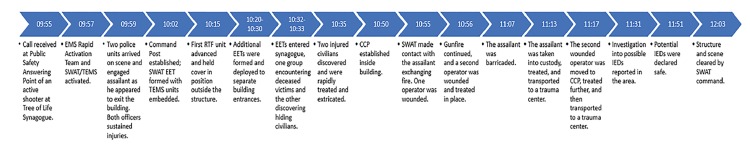
Timeline of EMS activity on scene during the Tree of Life synagogue mass shooting in Pittsburgh, October 27, 2018.EMS, Emergency Medical Services; SWAT, Special Weapons and Tactics; TEMS, Tactical Emergency Medical Services; EET, Emergency Entry Team; RTF, Rescue Task Force; CCP, Casualty Collection Point; IEDs, Improvised Explosive Devices.